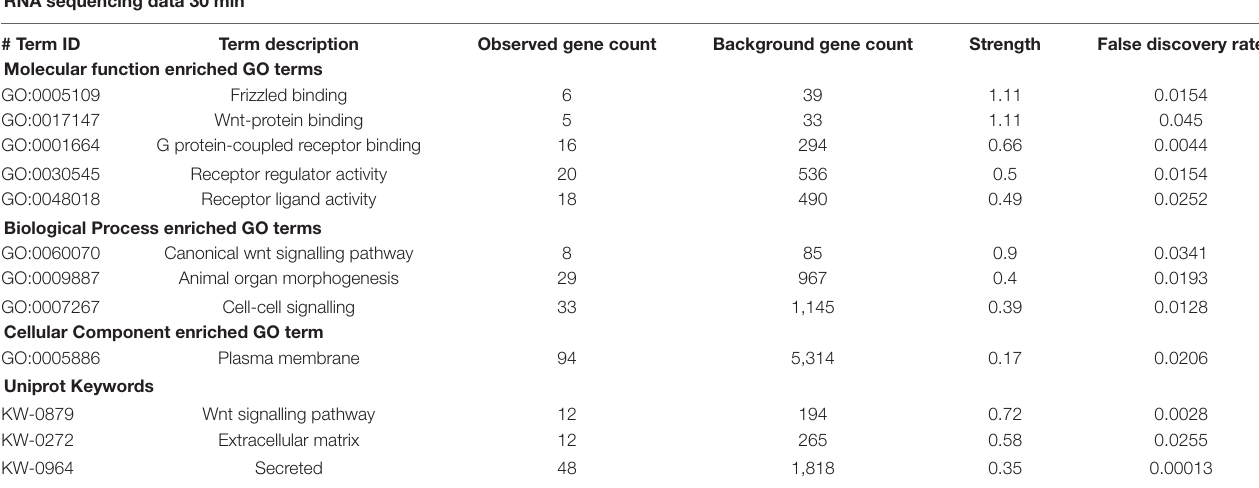
TABLE 1 | Enrichment of GO terms in RNA sequencing data. RNA sequencing data 30